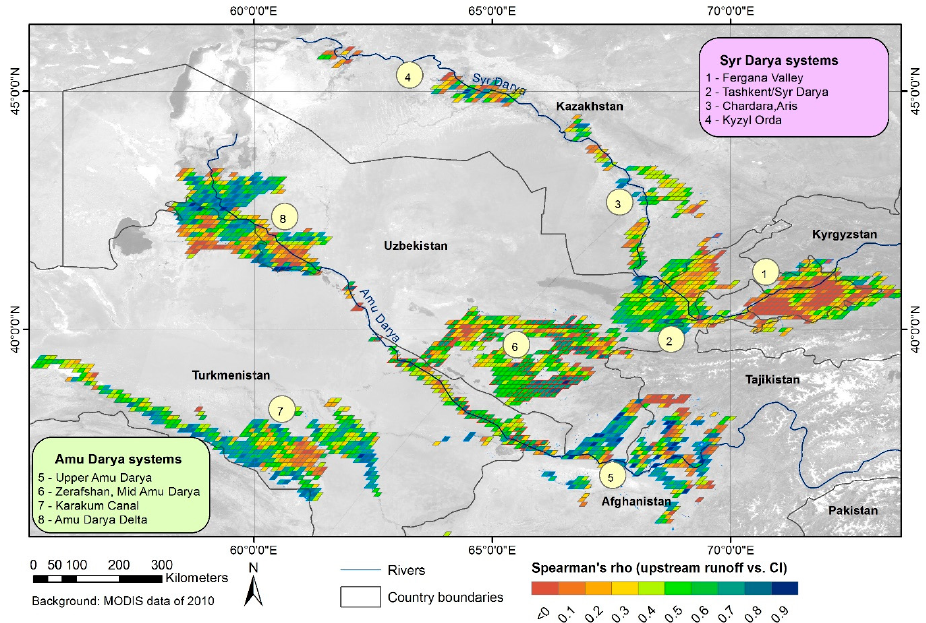
Figure 9. Spearman’s rho of correlation between the cropping intensity annually averaged in 10 km × 10 km grid cells (CI GRID ) and annual upstream runoff formation in hydrological years between 2000 and 2012 (13 years). Significant correlations (at 95% level) are highlighted in green to blue. Only grid cells with more than 100 MODIS pixels of the iCE were included (>625 ha).